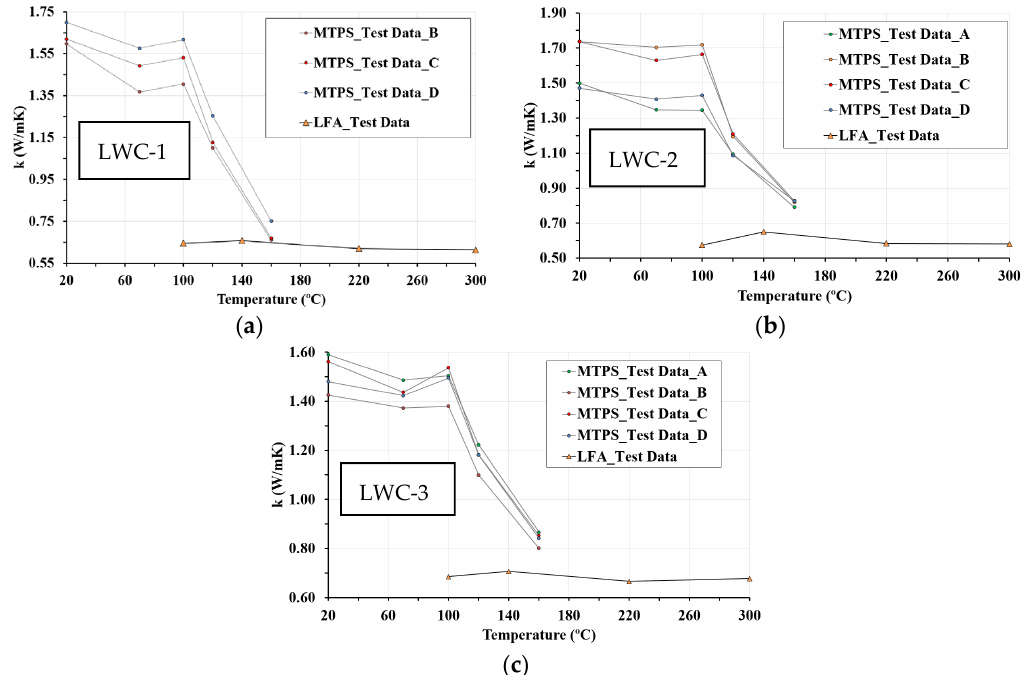
Figure 9. Comparison of thermal conductivity results between 20 and 300 °C: ( a ) LWC-1; ( b ) LWC-2; ( c ) LWC-3.